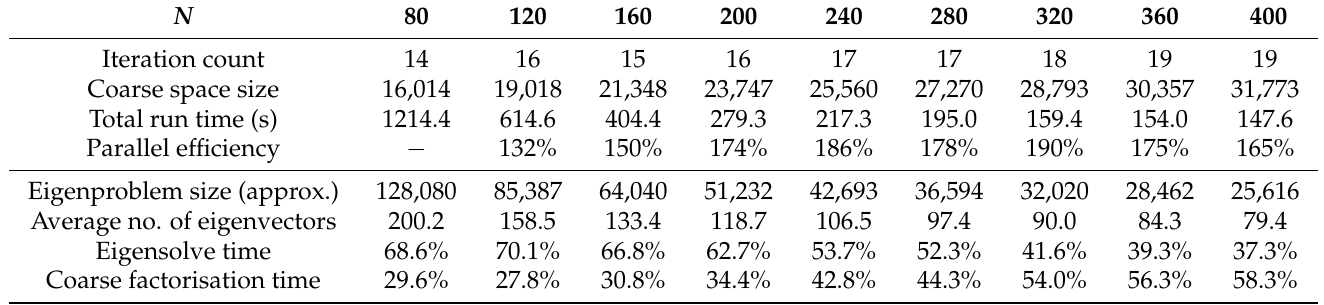
Table 12. Strong scaling results and timings for the homogeneous problem when using ORAS with H-GenEO ( 1 ) and a varying number of subdomains for k = 186.0 and h − 1 = 3200, giving a total of 2 10,246,401 dofs. A non-uniform decomposition into N subdomains is used, given by METIS. The average local eigenproblem size is given approximately as the number of dofs divided by N .